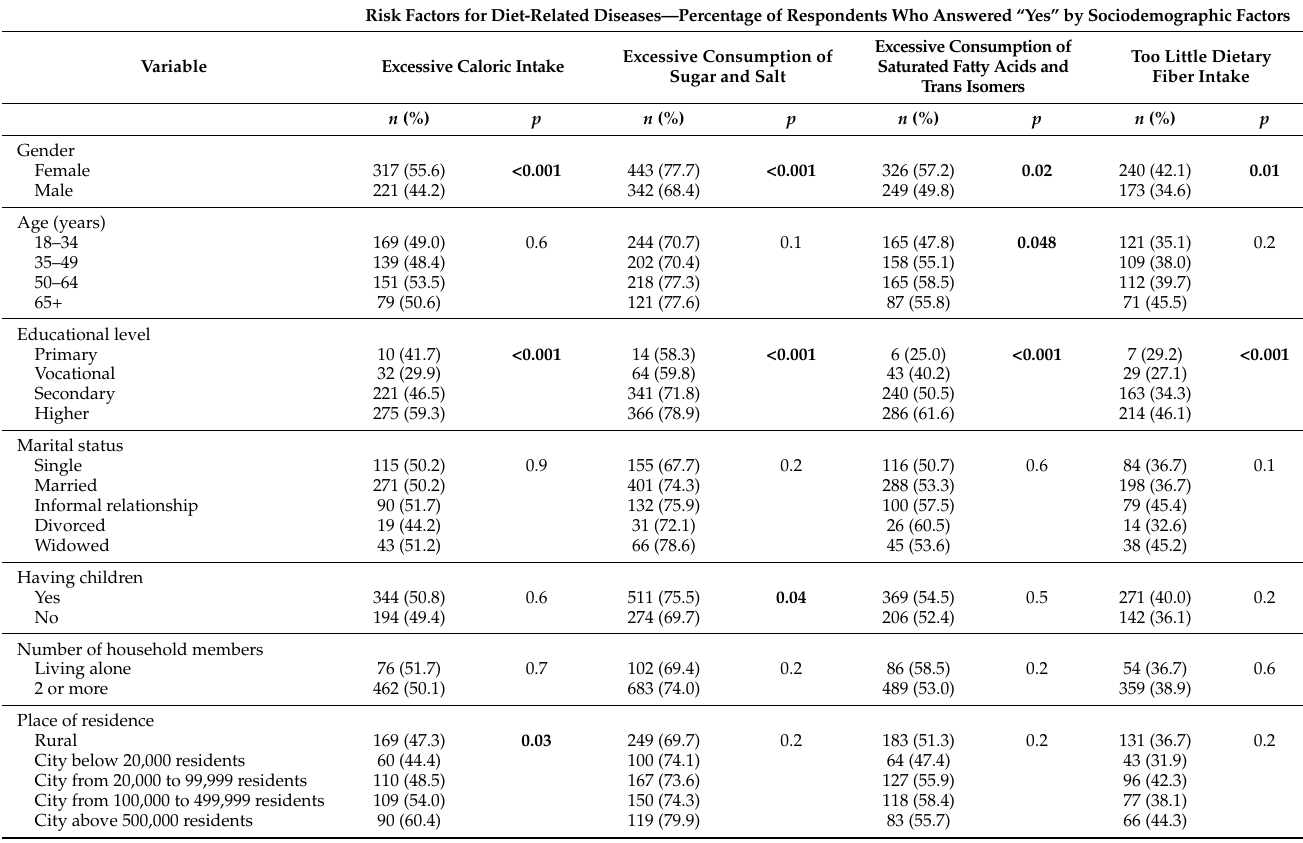
Table 4. Awareness of dietary patterns that increase the risk for dietary-related diseases ( n =